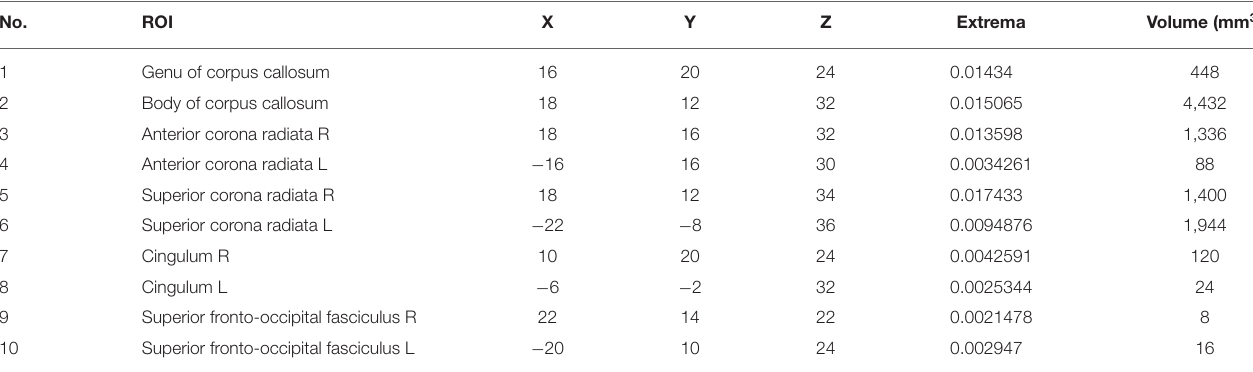
TABLE 3 | Regions that showed consistent fractional anisotropy (FA) reduction in patients with T2DM.